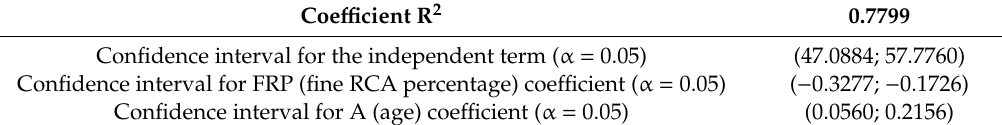
Table 14. Main results for the model obtained by multiple linear regression (Equation (2)).